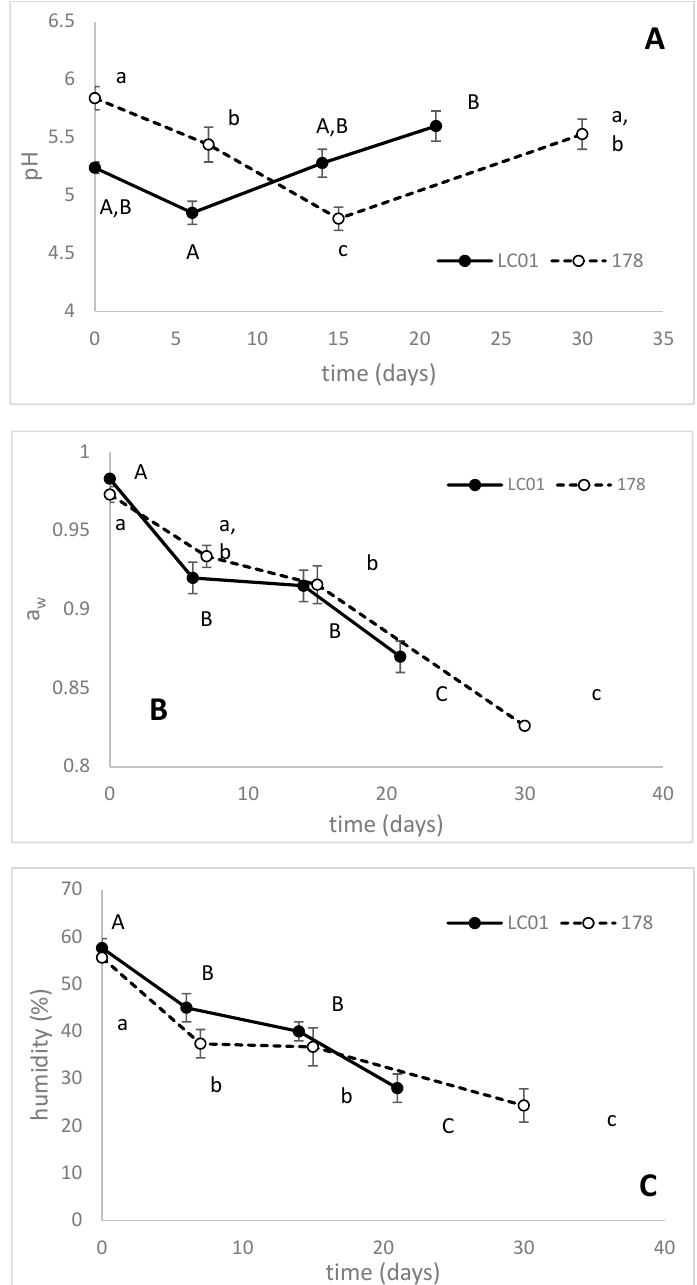
Figure 6. pH ( A ), a w ( B ) and relative humidity ( C ) in traditional sausages inoculated with Lb. casei LC01 or Lb. plantarum 178. Mean ± standard deviation. The letters indicate statistically significant differences throughout time (one-way ANOVA and Tukey’s test, p < 0.05): small letters, sausages inoculated with Lb. plantarum 178; capital letters, LC01.